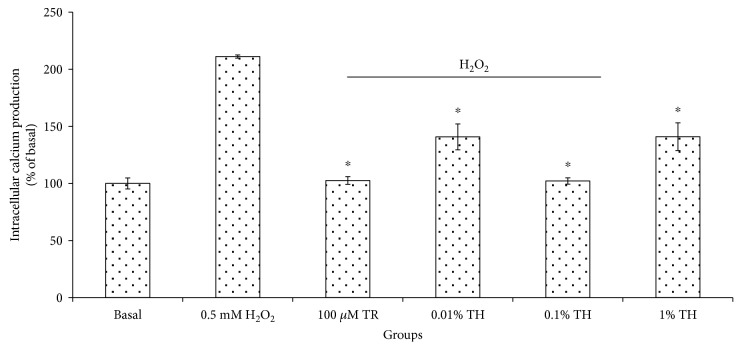
Percentage of intracellular calcium production in HUVECs pretreated with TH and induced with H2O2. The intracellular calcium (% of basal) of cells treated with TH shows a significant difference (∗p < 0.05) with the H2O2 group. Values are expressed as the mean ± SEM from three independent experiments. Asterisk (∗) represents the significantly different groups with the H2O2 group. Basal = untreated; TR = Trolox; TH = Tualang honey.